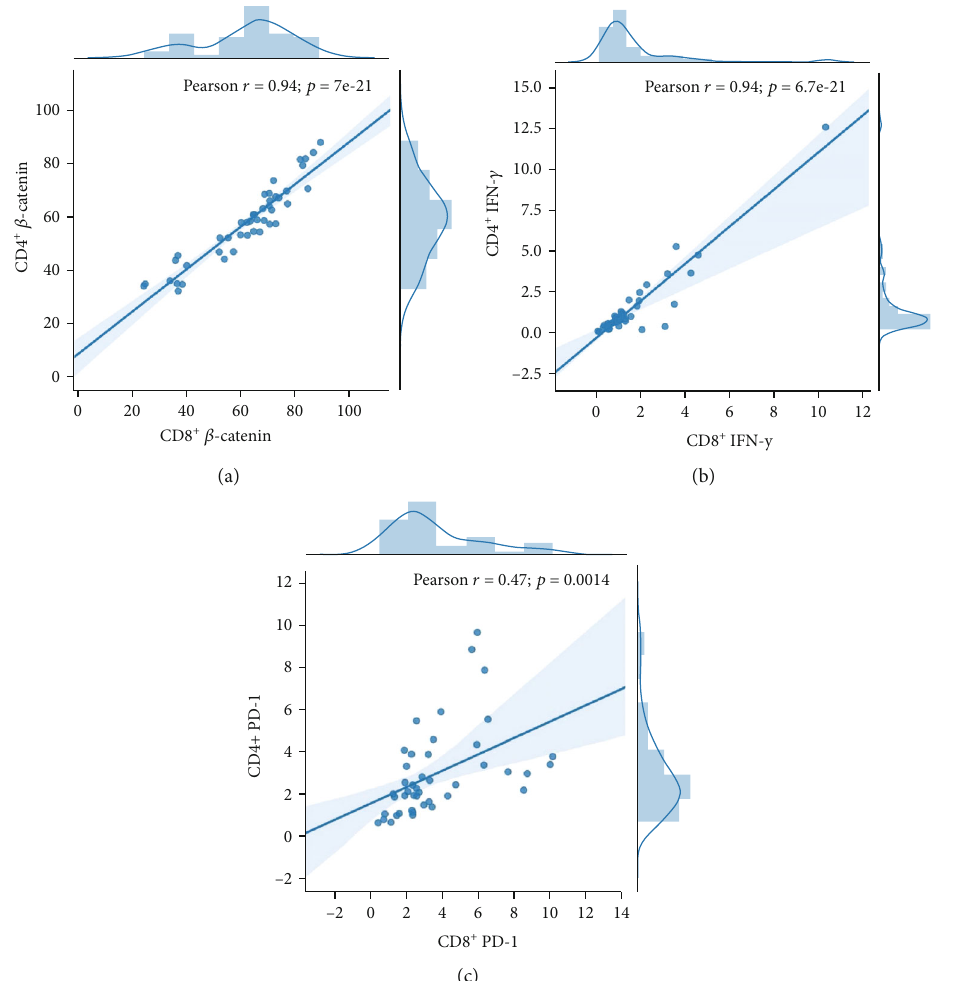
Figure 8: (a) The correlation of β -catenin on CD4 T cells and β -catenin on CD8 T cells. (b) The correlation of IFN- γ on CD4 T cells and IFN- γ on CD8 T cells. (c) The correlation of PD-1 on CD4 T cells and PD-1 on CD8 T cells ( n = 47